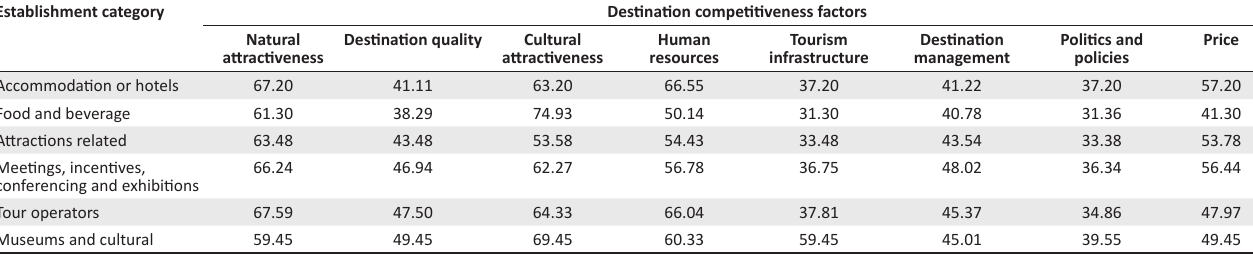
TABLE 3: Mean scores for indices of tourism establishment categories for competitiveness dimensions. Establishment